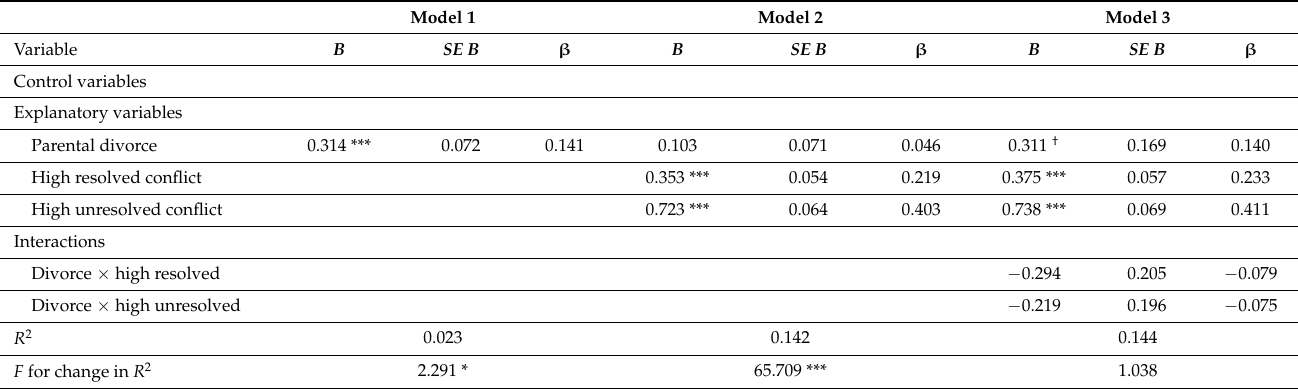
Table 8. Summary of the hierarchical multiple regressions for the variables predicting alienation in father-child